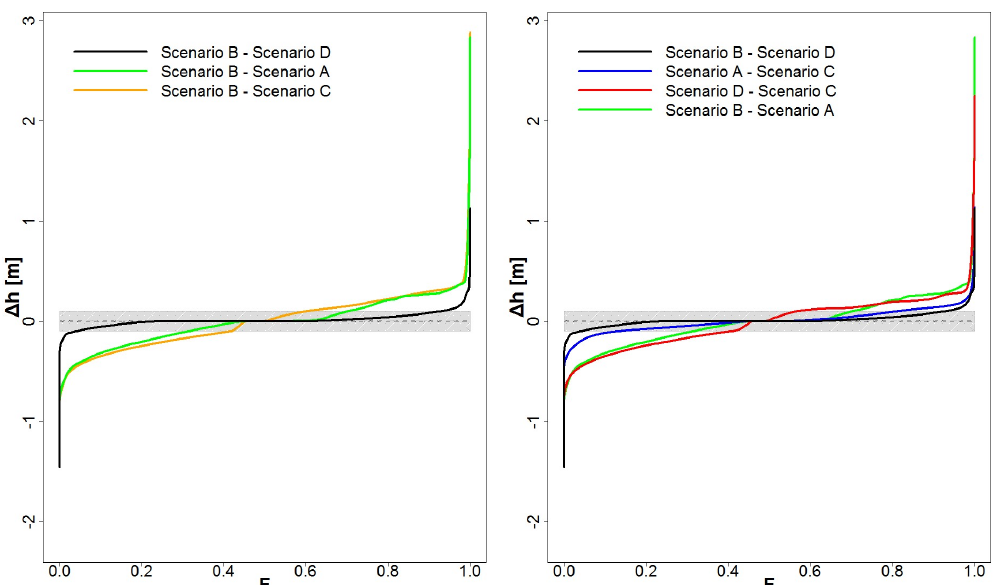
Figure 2. Cumulative distribution function of water depth differences between scenarios, (cid:49)h (i.e. differences between water depths simulated for two Scenarios X and Y); “Scenario X – Scenario Y” indicates (cid:49)h values computed as water depths simulated for Scenario X minus water depths simulated for Scenario Y; grey dashed areas highlight non significant (cid:49)h values (i.e. absolute values lower than